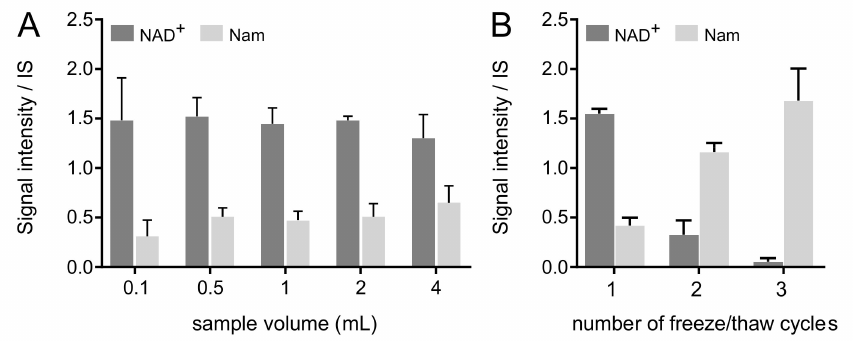
Figure 4. LC-MS/MS metabolite signal intensity per internal standard for NAD + and Nam of human whole blood according to: ( A ), aliquot volume (0.1, 0.5, 1, 2, 4 mL) at blood draw. Average ± SD values from 3 donors (per aliquot and subject n = 1 for 0.1, 0.5 and 2 mL, n = 2 for 4 mL, and n = 3 for 1 mL); ( B ), number of freeze–thaw cycles (taken on 1, 13, 21 days). Average ± SD values from 3 donors ( n = 3). NAD + : nicotinamide adenine dinucleotide; Nam: